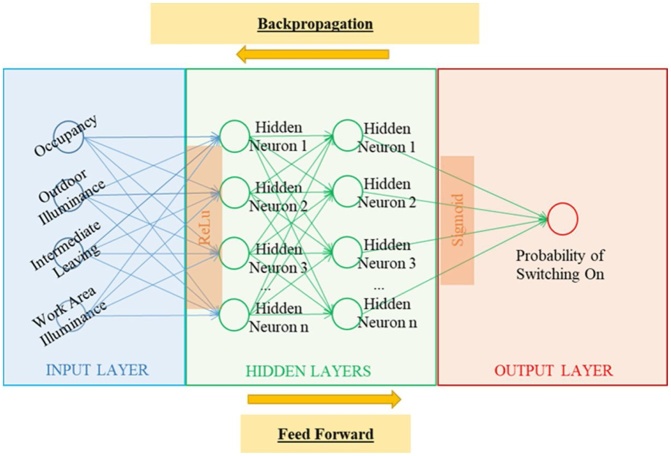
Scheme of the Back Propagation – based Artificial Neural Network (ANN) [1].